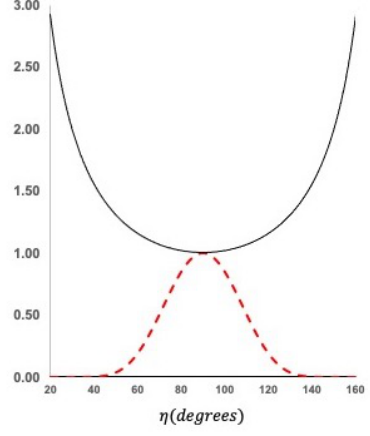
Figure 2. Plot of the Gamov factors for electron, dashed red and positron, solid black, with θ 1 = θ 2 , E 1 = E 2 = 1